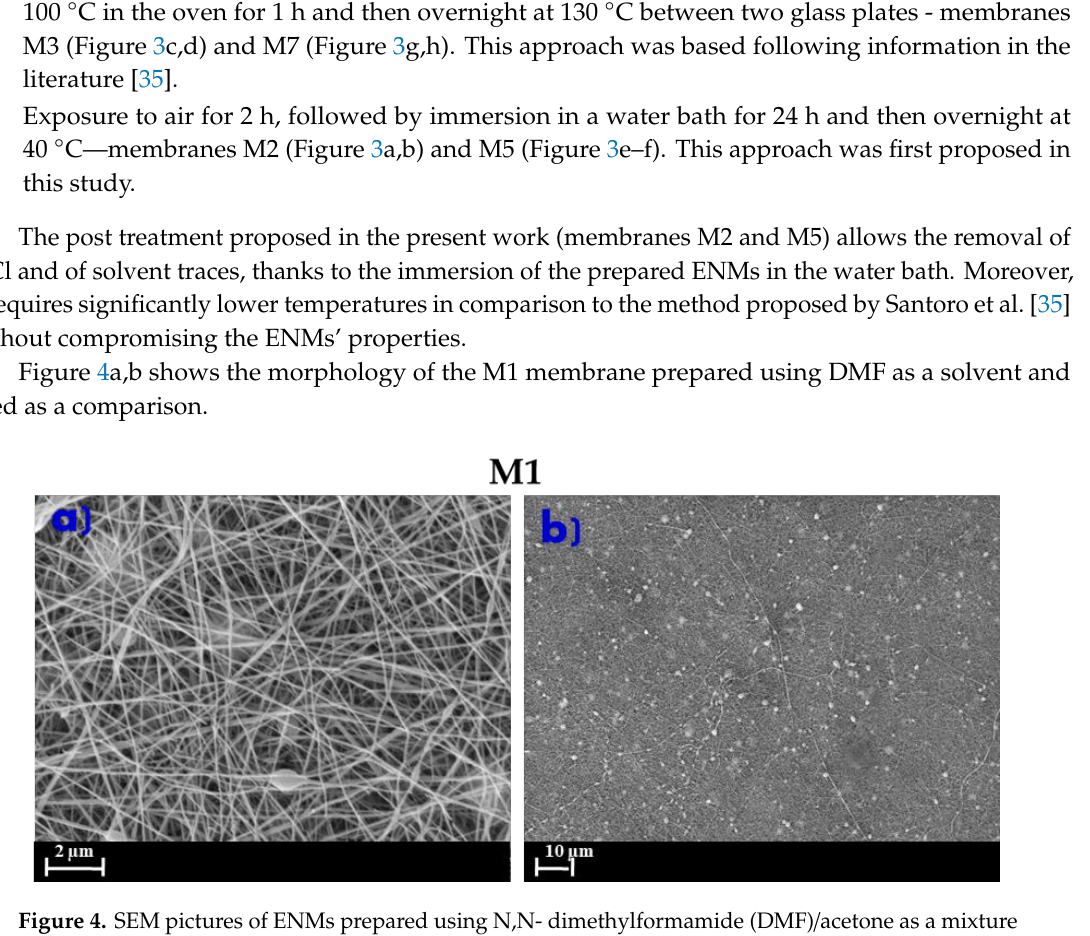
Figure 3 . SEM pictures of the ENMs using dimethyl sulfoxide (DMSO)/acetone as a mixture of solvents at different post-treatments with and without LiCl. M2 ( a ) and ( b ); M3 ( c ) and ( d ); M5 ( e ) and ( f ); M7 g and h. Conditions of electrospinning process: 15 kV voltage and 15 cm of needle to collector distance.